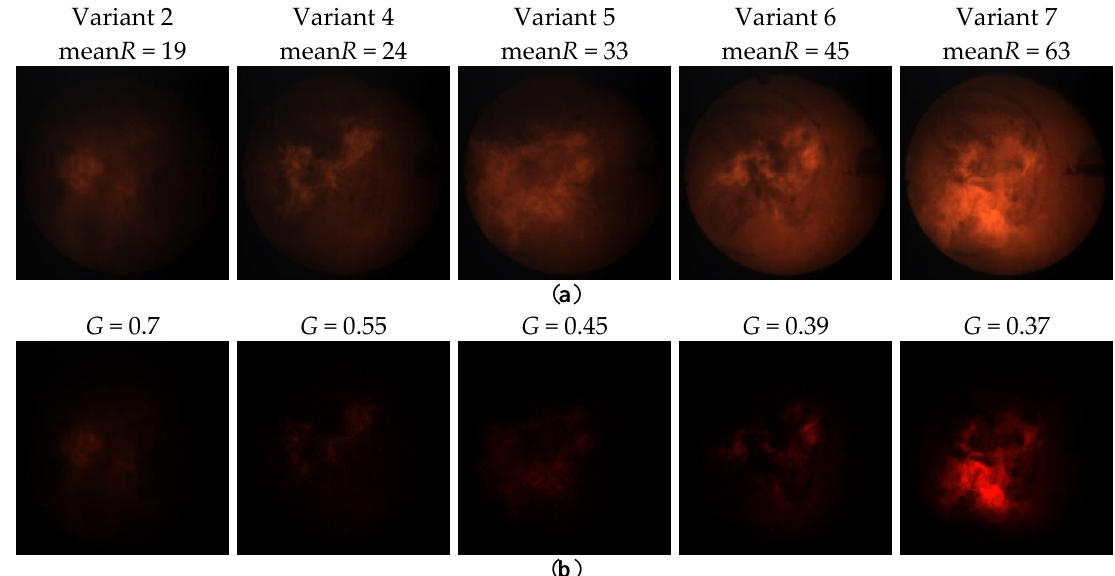
Figure 5. Gamma correction for exemplary flame images belonging to different variants: ( a ) input images; ( b ) images after gamma correction. The images show that the adaptive selection of the gamma correction coefficient effectively eliminates the image background, regardless of the average intensity of the R component. Thanks to this, better conditions for segmentation of the flame area are created.